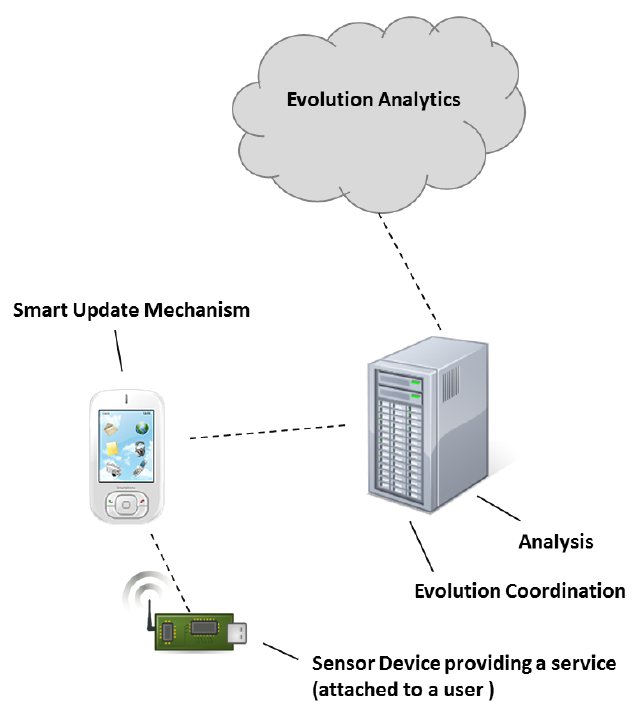
Figure 4. Deployment of an EVA in an IoT scenario